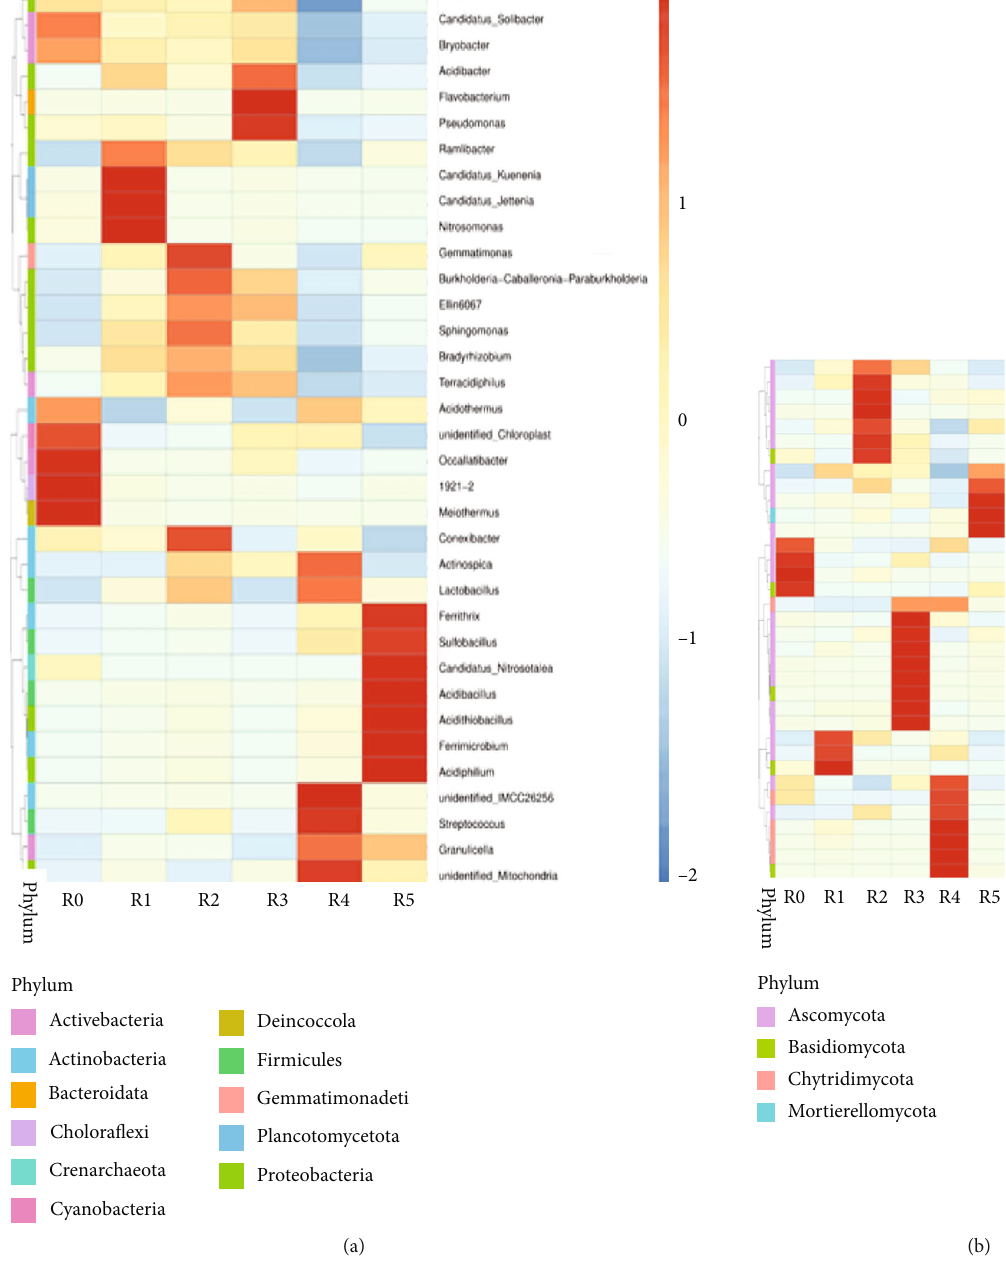
Figure 3: The heatmap analysis of bacteria and fungi species abundance clustering at the genus level. The genus classi fi cation position clustering (horizontal) and top 35 genera sample clustering (vertical clustering). Di ff erent color means the di ff erent relative abundance of the genus (red means great